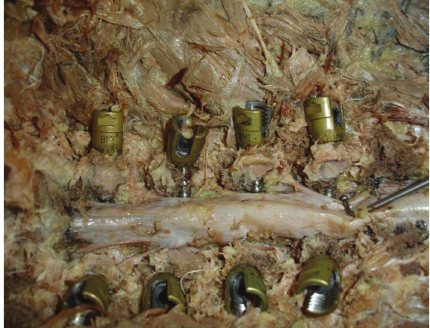
Figure 7: Pedicle walls after laminectomy. 15-degree screws are on the upper side and 10-degree screws are on the lower